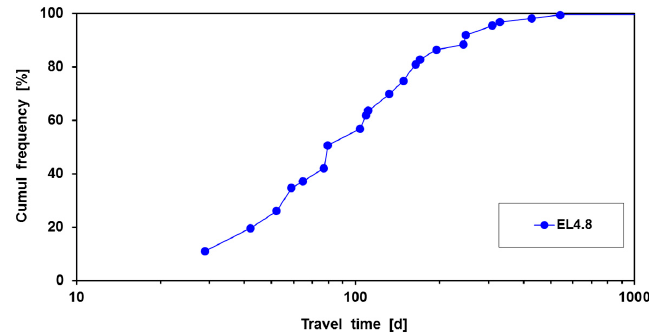
Figure 10. The cumulative frequency distribution of travel times from the recharge basin to the schematized seven recovery wells around it. Flowlines in aquifer layers D and E are excluded because of their very low contribution (together 0.42%).